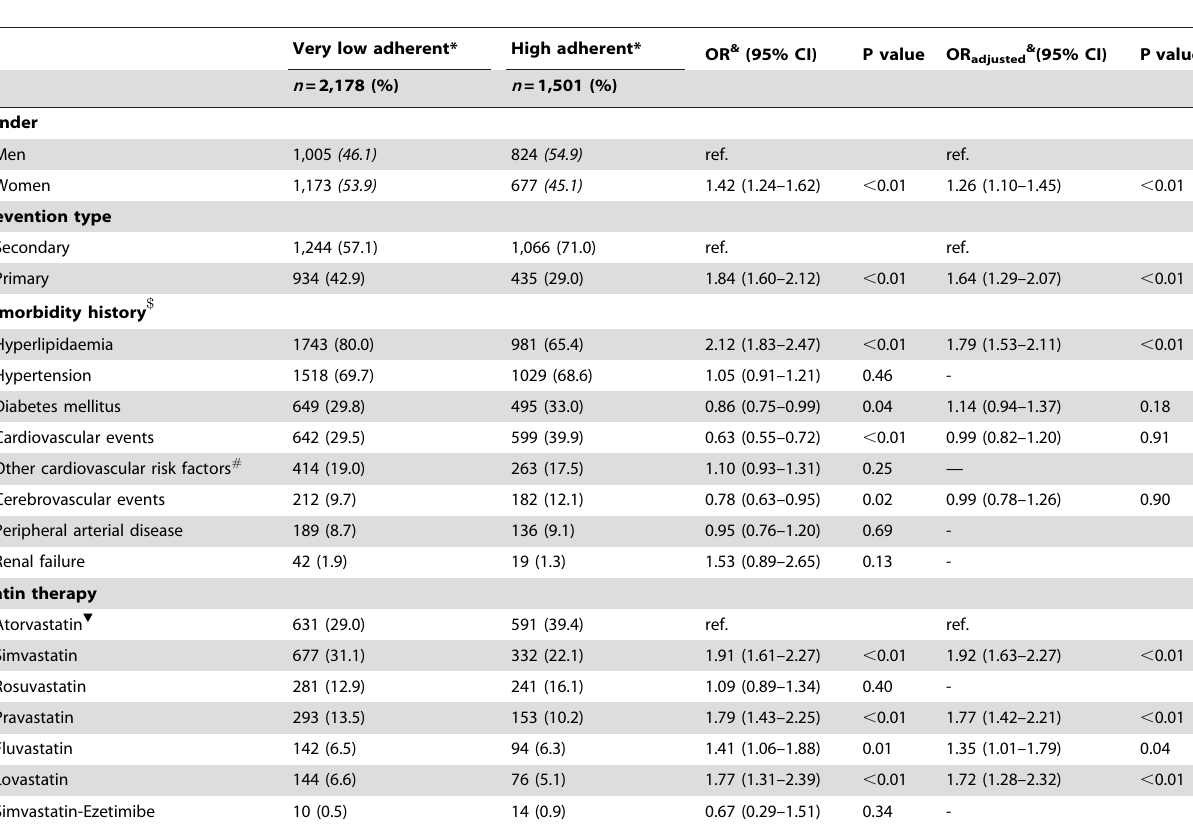
Table 3. Predictive factors at 4-year follow-up of very low adherent ( n =2,178) compared to high adherent ( n =1,501) to the statin